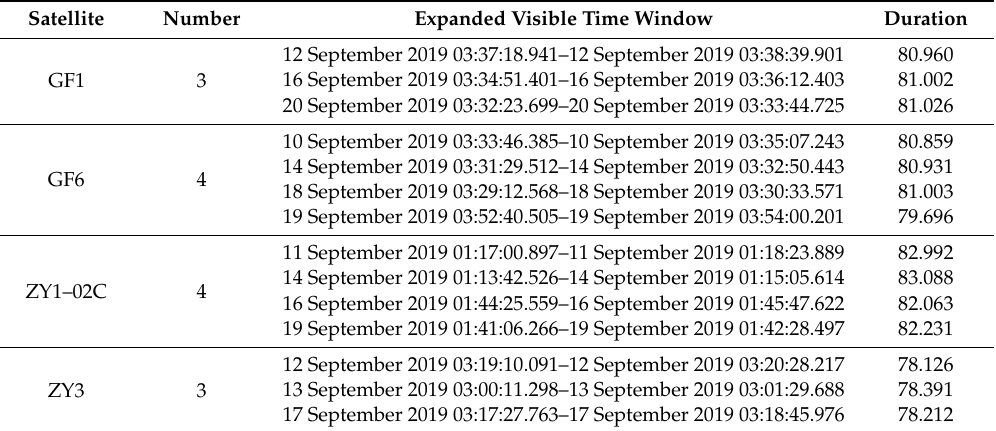
Table A1. Expanded visible time window of Hubei.